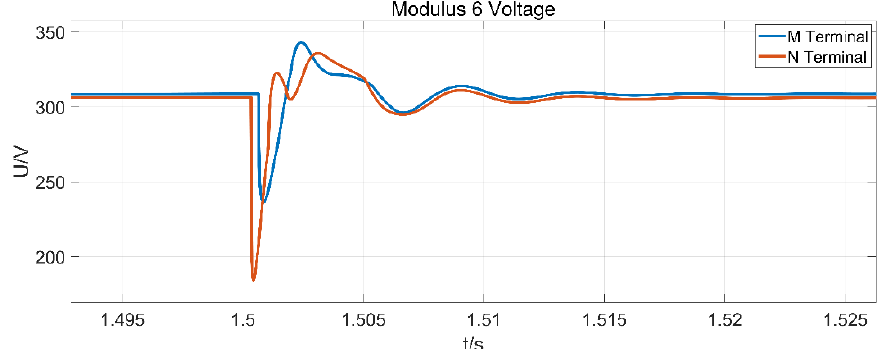
Figure 7. Fault voltage and fault current.